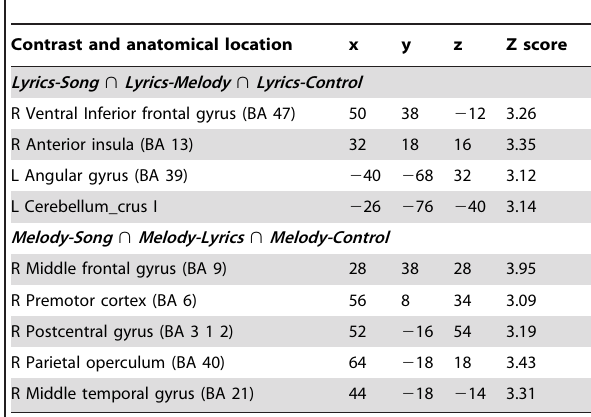
Table 2. Brain regions specifically activated by one component of songs (Lyrics or